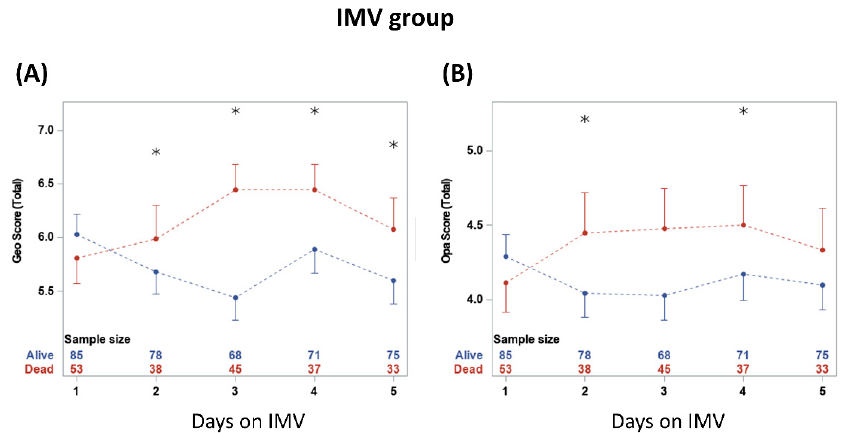
Figure 4. ( A ) geographic extent and ( B ) opacity chest X-ray scores taken on five consecutive days. * denotes significant difference in score value between survivors and non-survivors at a time point. The numbers show the sample sizes for each group at each time point. From two-way repeated measures ANOVA, the time and group*time had significant effects ( p < 0.05). Significant differences from t -tests with the Bonferroni–Holm correction are indicated as * p <